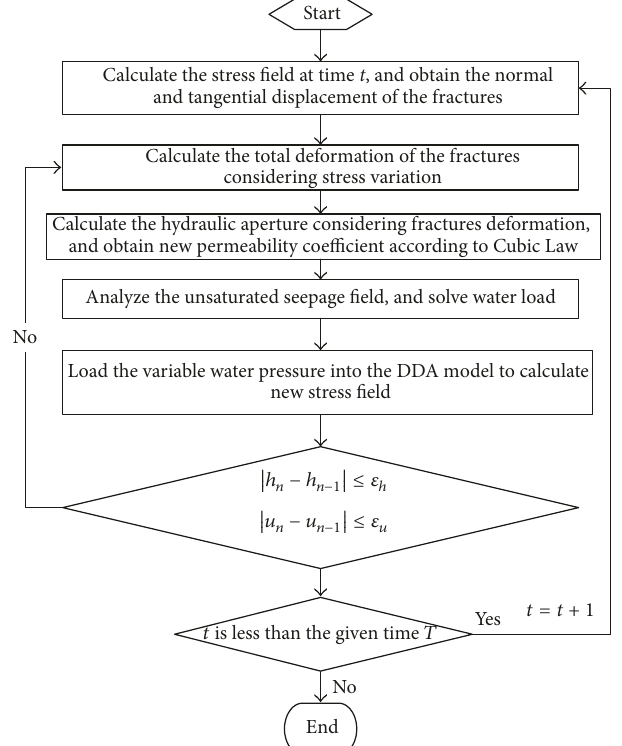
Figure 2: Flow chart of the unsaturated hydromechanical coupling analysis using